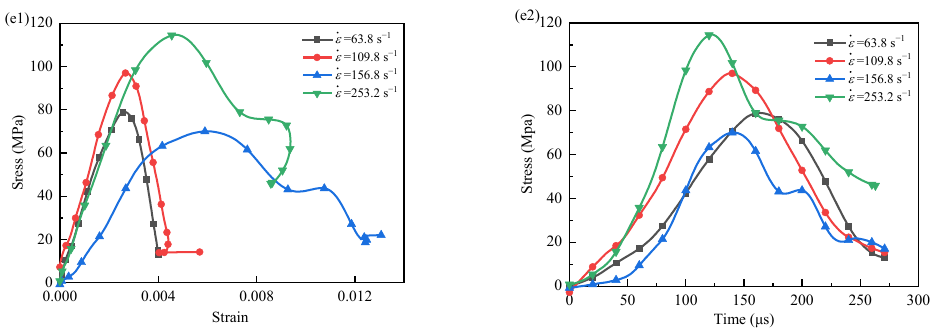
Figure 10. Stress-strain curve and stress history curve with different length–diameter ratios (( a – e ) for 0.6~1.4).